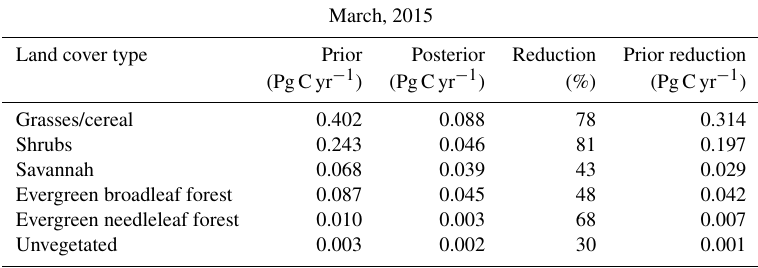
Table B1. Uncertainty reduction of total CO 2 Australian flux (in PgCyr − 1 ) classified by MODIS ecotype (March, 2015).